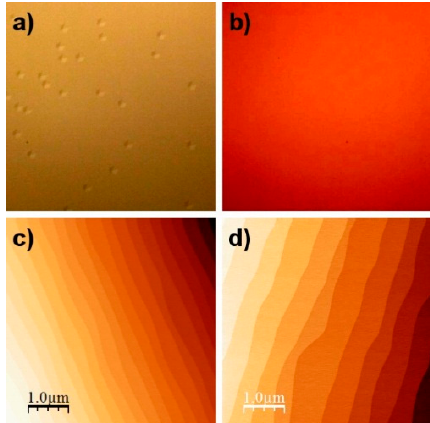
Figure 45. Nomarski and AFM images of etched SiC(0001). ( a ) Nomarski image of the SiC(0001) surface following a 30 min etch at 1450 °C. The small features on the surface are pits. ( b ) Nomarski image of etched sample for 0-min. AFM images of ( c ) an area in ( a ) (TW ≈ 250 nm); ( d ) an area in ( b ) (TW ≈ 250 nm) [156]. The optical images in ( a ) and ( b ) are both 150 µm × 150 µm.